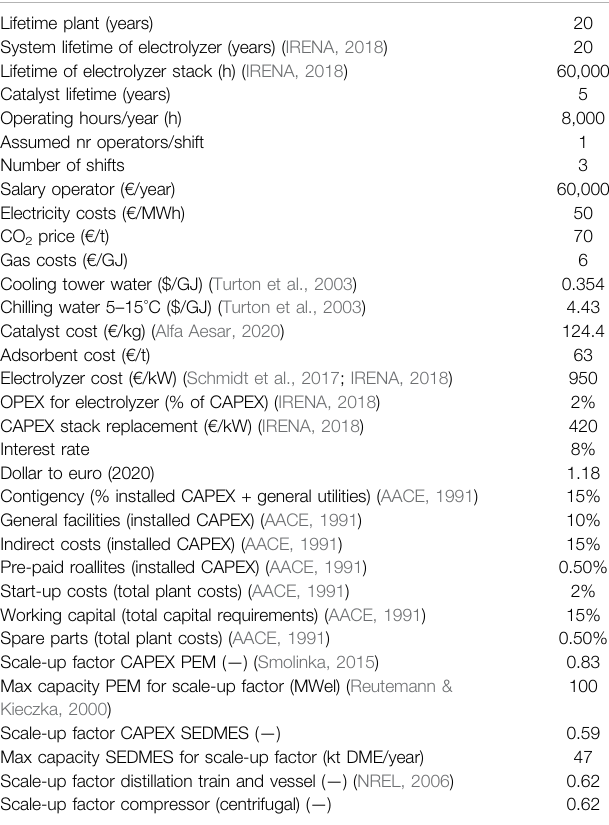
TABLE 3 | Summary of the assumed key economic parameter indicators and assumptions for the power-to-X technology SEDMES process base case. Lifetime plant (years)